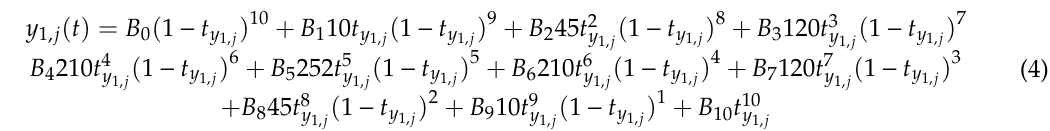
Figure 2. Definition of the parameter t used in the Bezier curve. 3. Aerodynamic Shape Optimization 3.1. Design Variables Here, in the aerodynamic shape optimization, the design variables were the Bezier control points